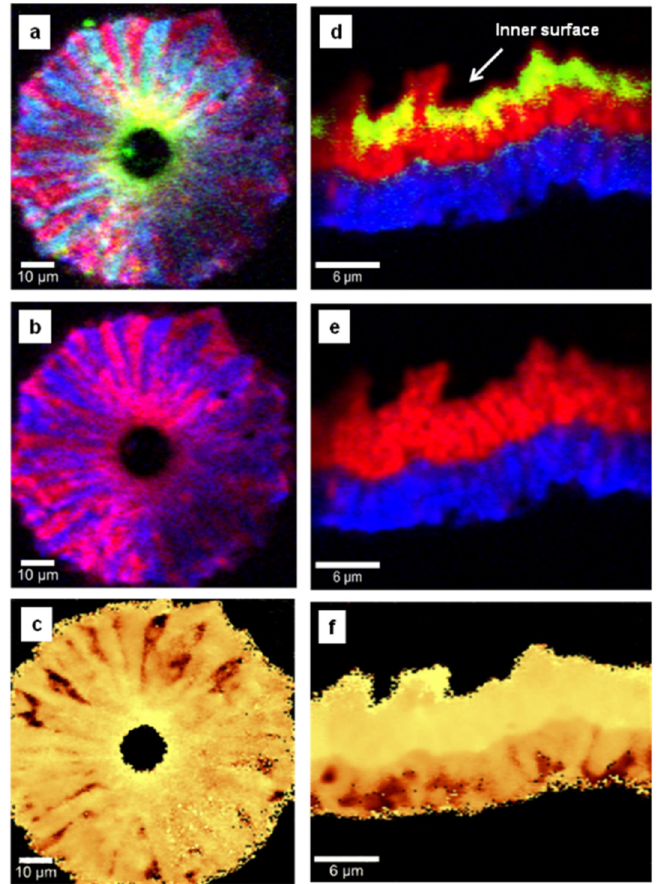
Figure 5. Side-wall confocal Raman mapping images of: ( a )–( c ) a heavily boron-doped film and its corresponding stress mapping analysis, and ( d )–( f ) two consecutive layers grown without and with boron addition, together with the associated stress map. Red, blue, and green pseudo-colors are used for diamond, boron, and carbon impurities, respectively. Yellow pseudo-color in the stress images corresponds to higher induced